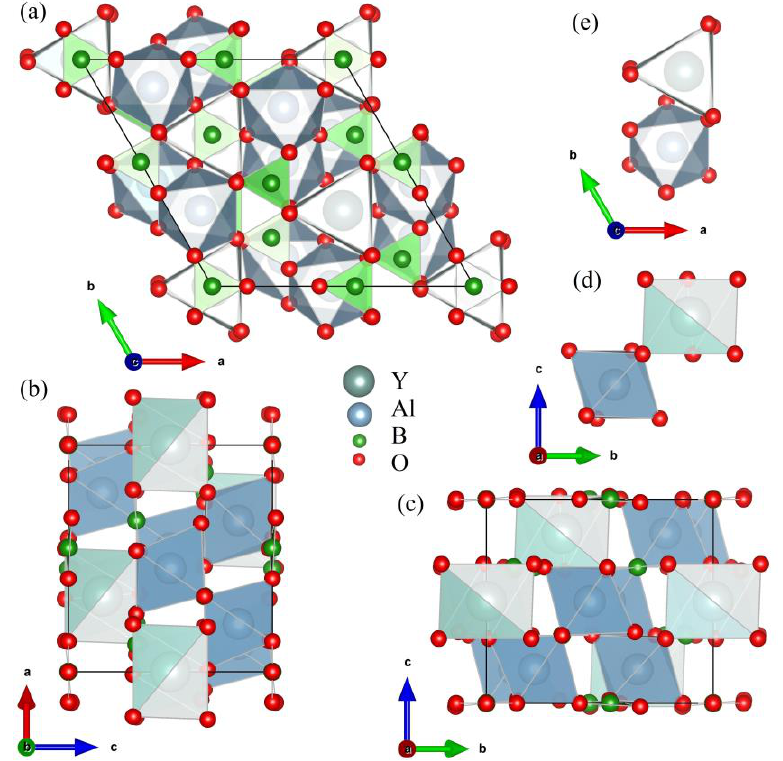
Figure 1. Projections of the YAl 3 (BO 3 ) 4 unit cell along the c axis ( a ), the b axis ( b ), and the a axis ( c ). Projections of the YO 6 trigonal prism and AlO 6 distorted octahedron in the YAl 3 (BO 3 ) 4 unit cell, along a axis ( d ) and the c axis ( e